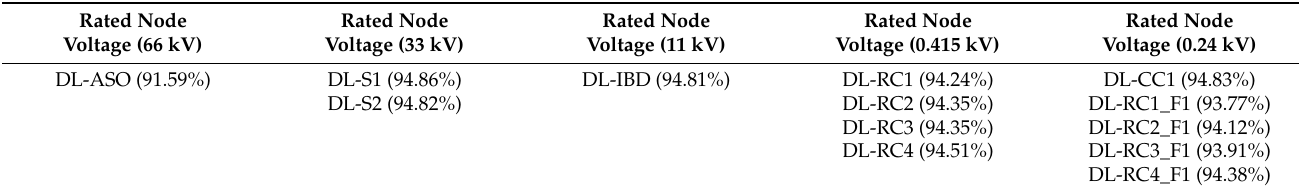
Table 2. Benchmark Network Node Voltage outside Tolerance Limits.